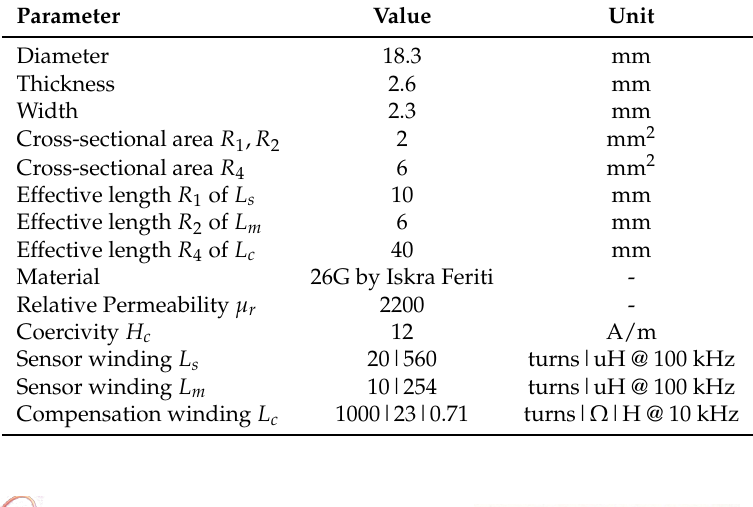
Table 1. Structural and electrical parameters of the 40A9R core.